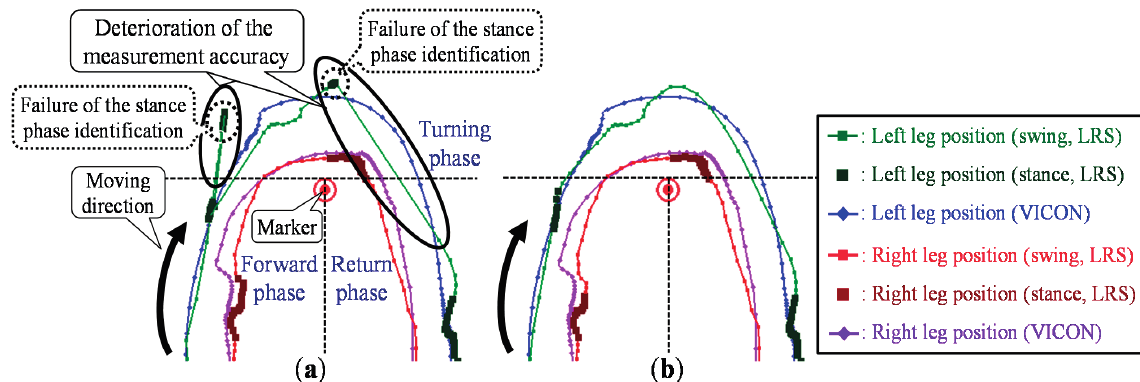
Figure 13. Leg tracking result in a situation where the left leg was hidden. ( a ) Method 2: without interpolation. ( b ) Method 3: with